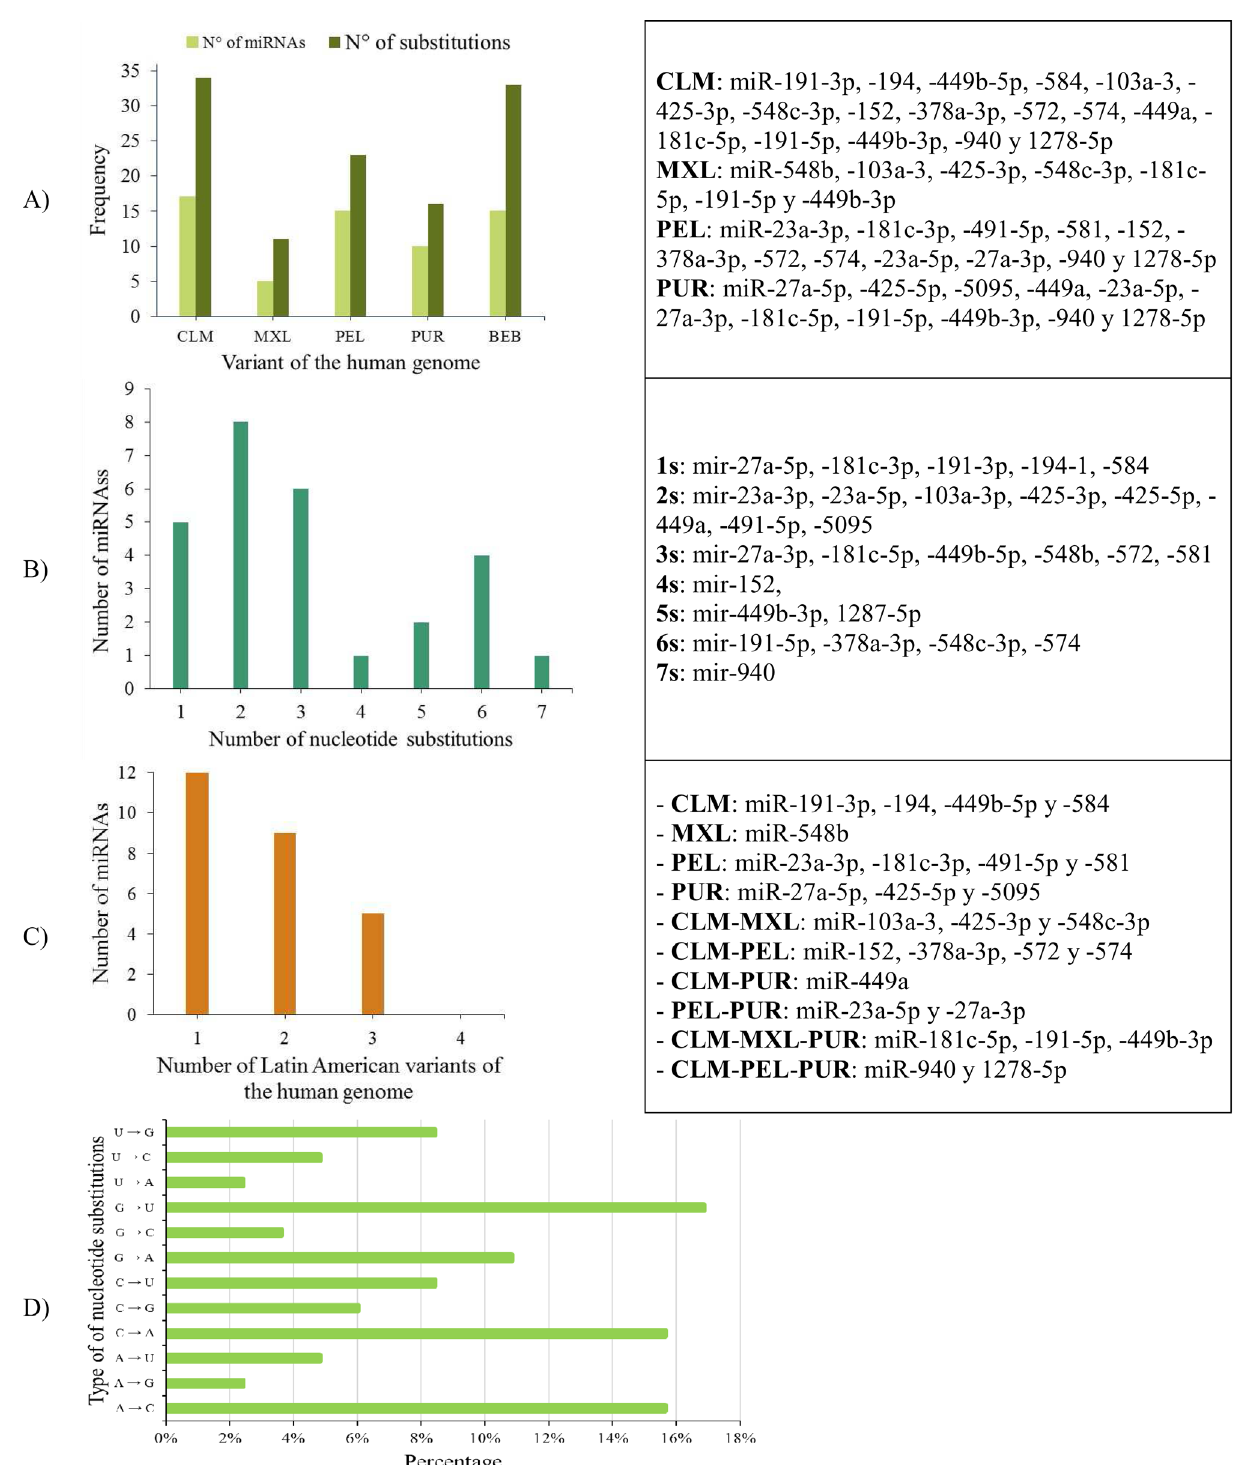
Figure 7. A ) Number of miRNAs and nucleotide substitutions found in each human genomic variant; B ) Number of miRNAs with between 1 and 7 nucleotide substitutions; C ) Number of miRNAs with nucleotide substitutions in one, two or three genomic variants in the Latin American human genome, and D ) Percentage of types of nucleotide substitutions in the miRNA sequences associated with CC in the selected human genome